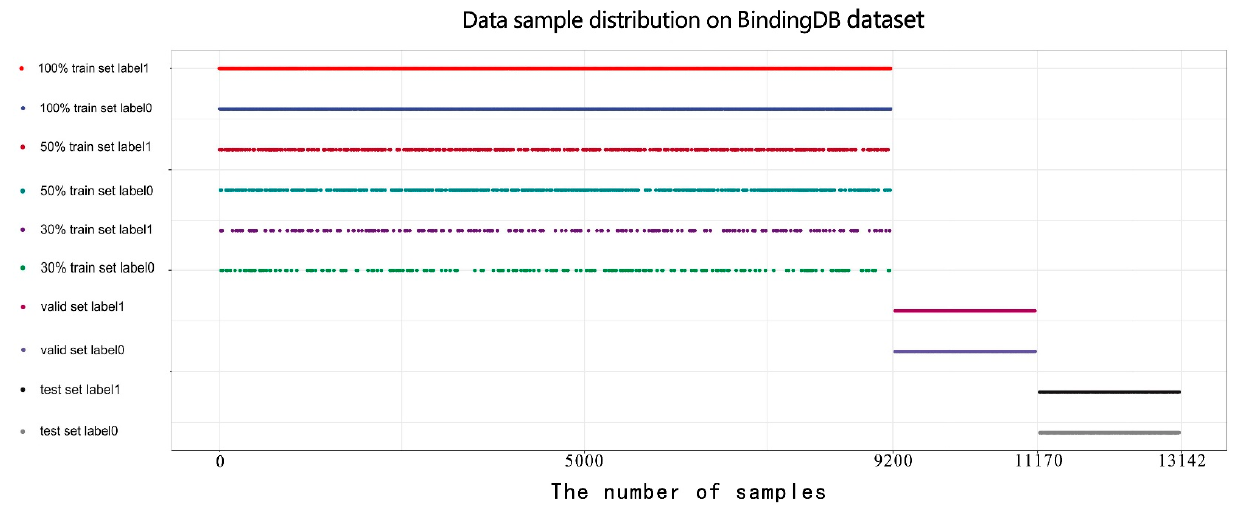
Figure 2. Data sample distribution on our customized BindingDB dataset.